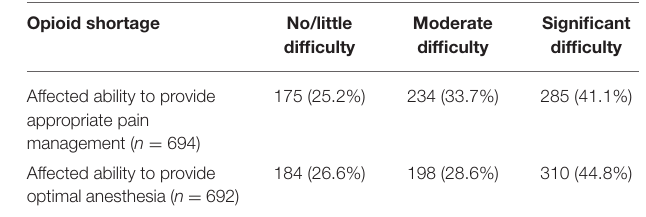
TABLE 4 | Veterinarians’ reported frequency rates for dispensing specific opioids in a clinic